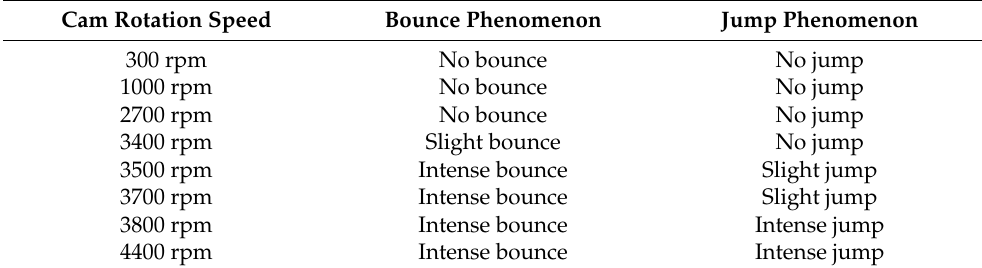
Table 4. Bounce and jump phenomena at different cam rotation